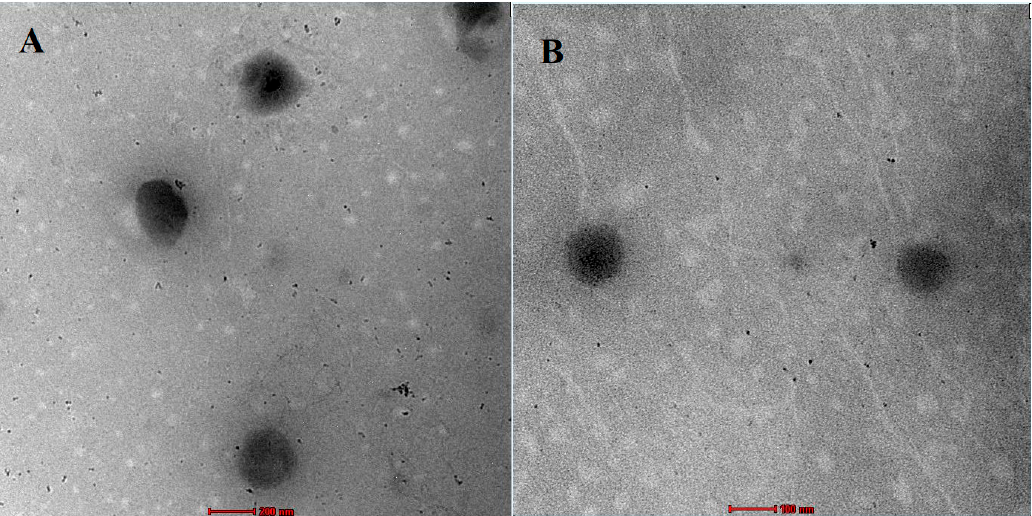
Figure 5. TEM images of H6-SNP. ( A ) Represents lipid nanoparticles (H6-SNP) H6-SNP at 200 nm scale. ( B ) Represents micelles, which are additionally found along with H6-SNPs, at 100 nm scale.